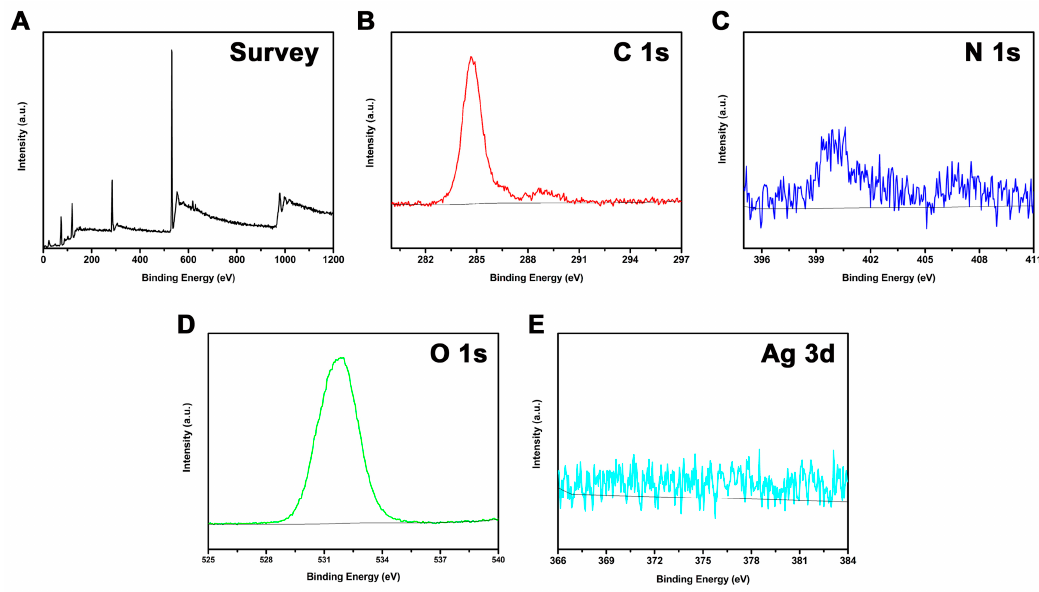
Figure 4. ( A ) XPS survey spectrum, ( B ) C 1s spectrum, ( C ) N 1s spectrum, ( D ) O 1s spectrum, and ( E ) Ag 3d spectrum of SG-Ag/PAN electrospun fibers.